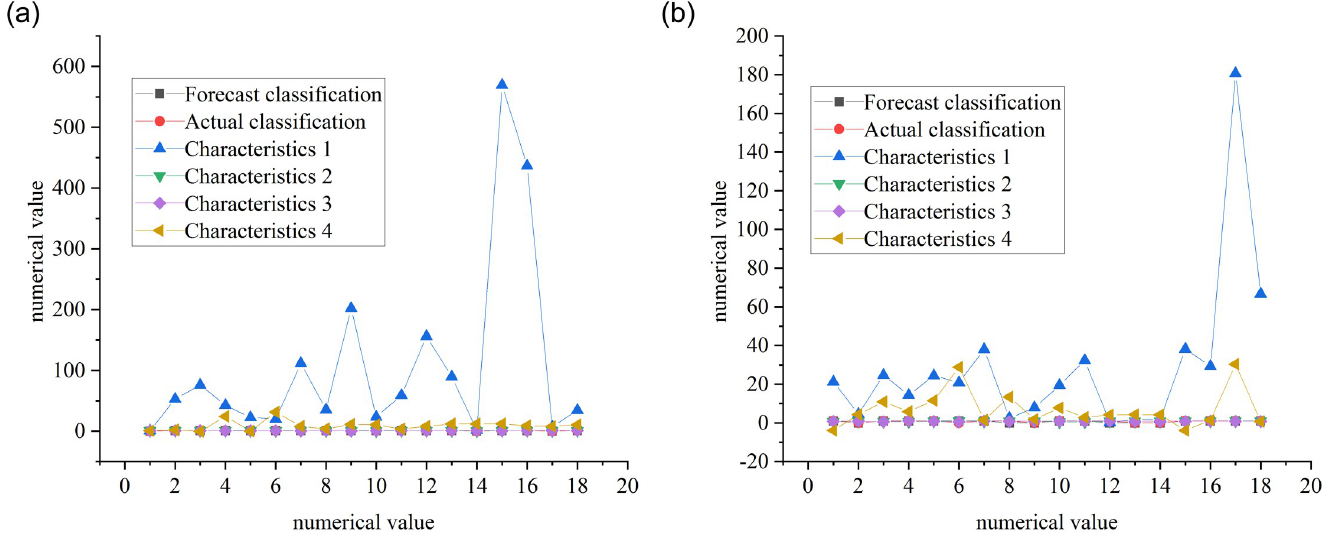
Fig 9. Classification results of BP-GA model (100 training samples). ((a) classification results of BP-GA model on training sample set, (b) represents classification results of BP-GA model on test sample set).